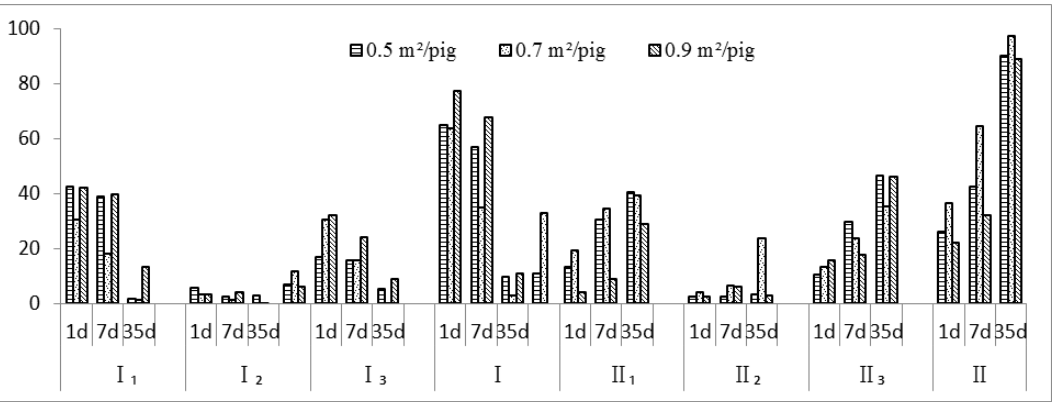
Figure 3. Spatial distribution of excretion rate of pigs with different stocking densities.